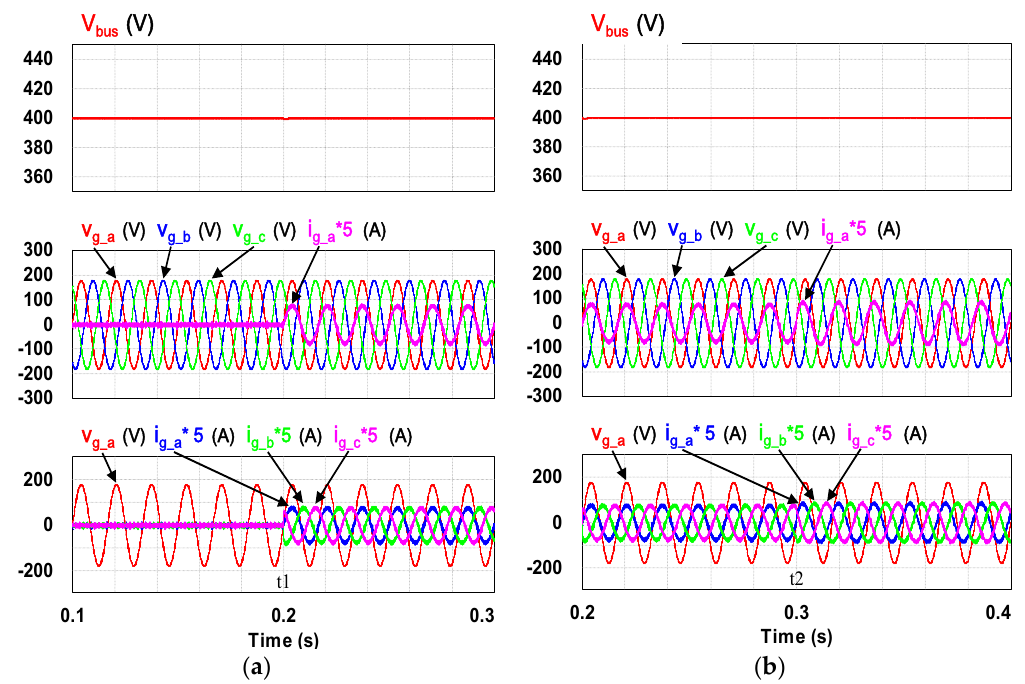
Figure 19. The detailed view of Figure 18b: ( a ) near t1; ( b ) near t2.